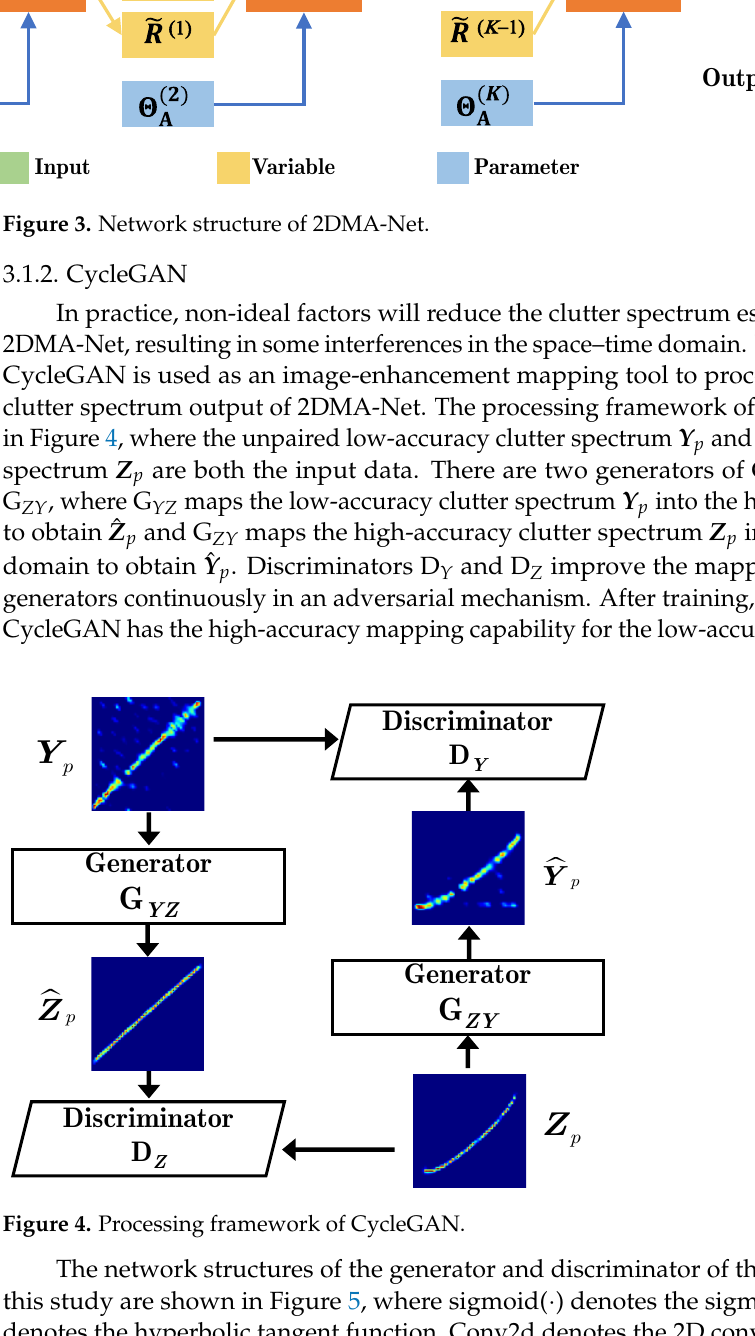
Figure 3. Network structure of 2DMA-Net.